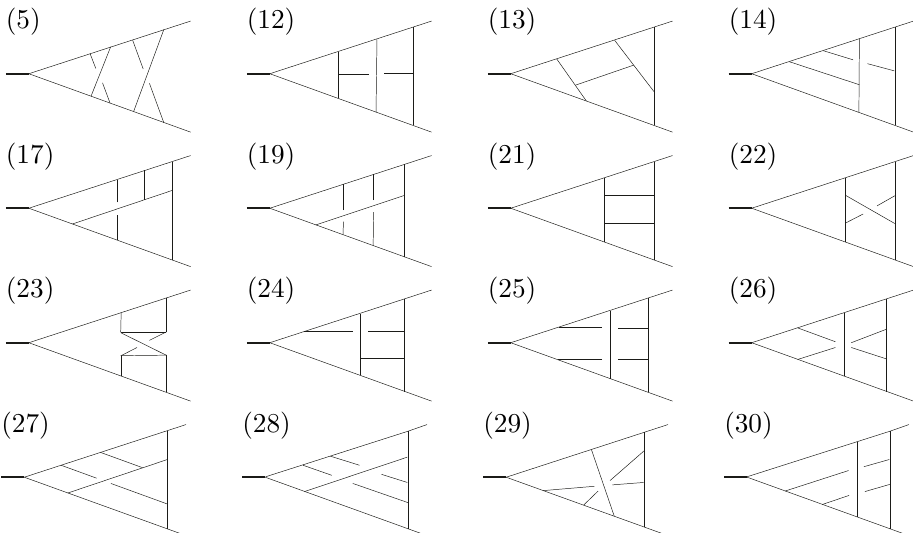
Figure 1 . Irreducible trivalent topologies for the N = 4 Sudakov form factor at four loops. Three integrals appear in both the planar-color and non-planar-color